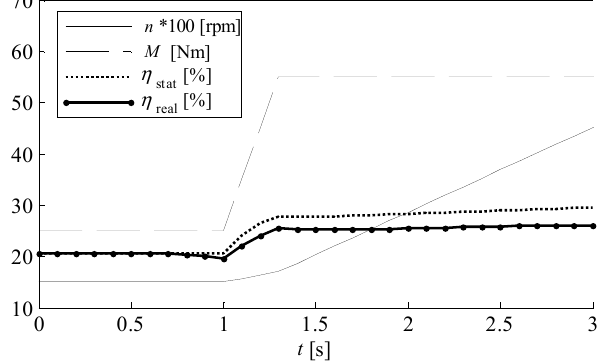
Figure 3. Engine efficiency in dynamic states.